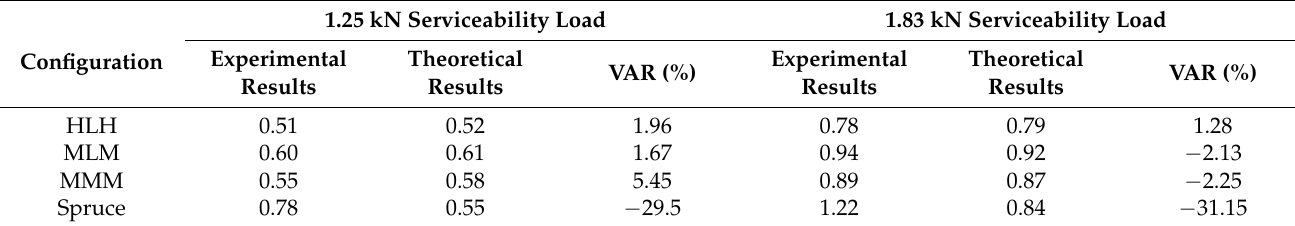
Table 5. Comparisons of the experimental and theoretical results.